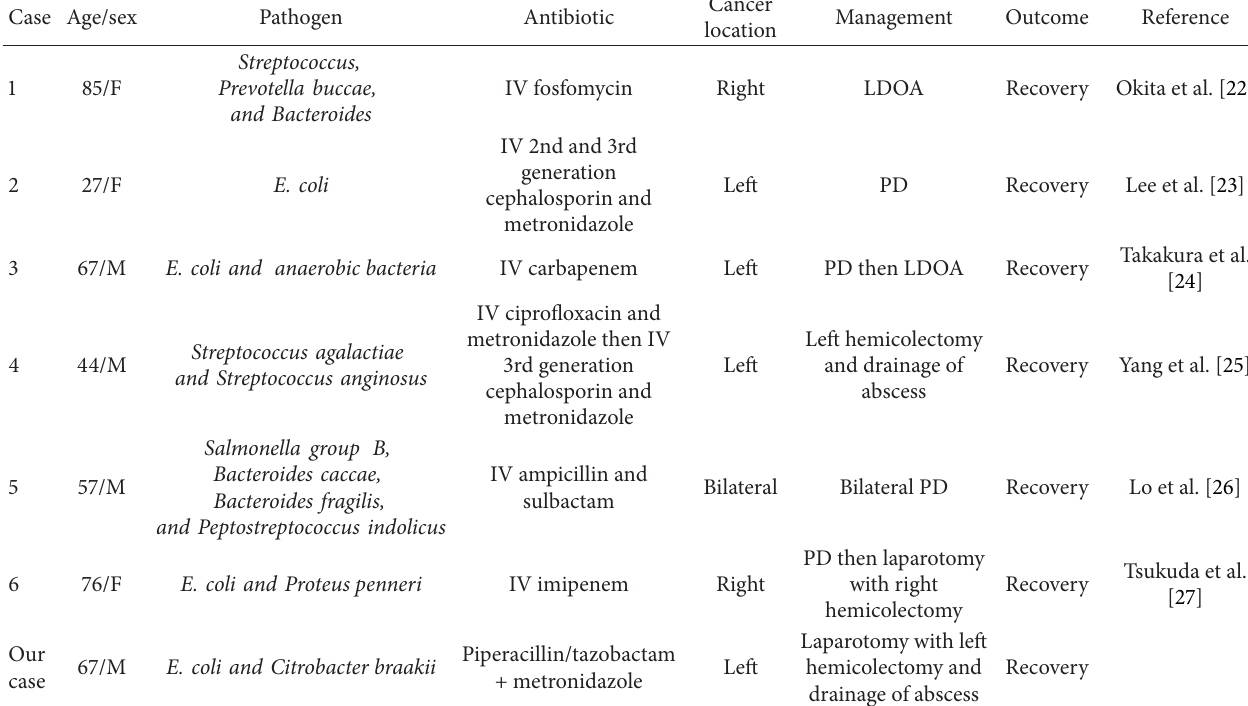
Table 4: Summary of some cases of colon cancer complicated with psoas abscess reported between 1990 and